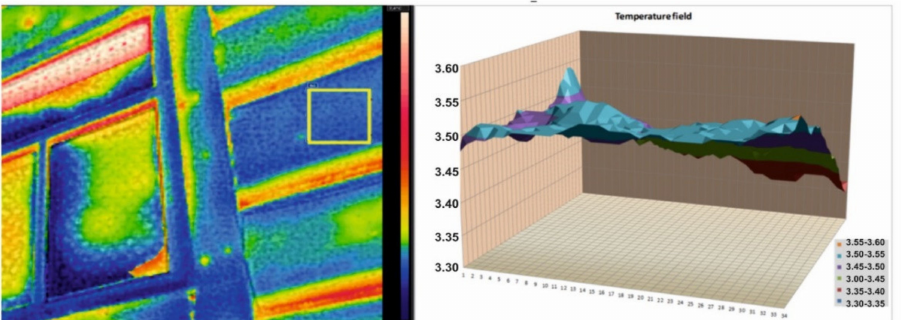
Figure 13. Sample precision thermogram. Analysis of temperature field distribution in the selected